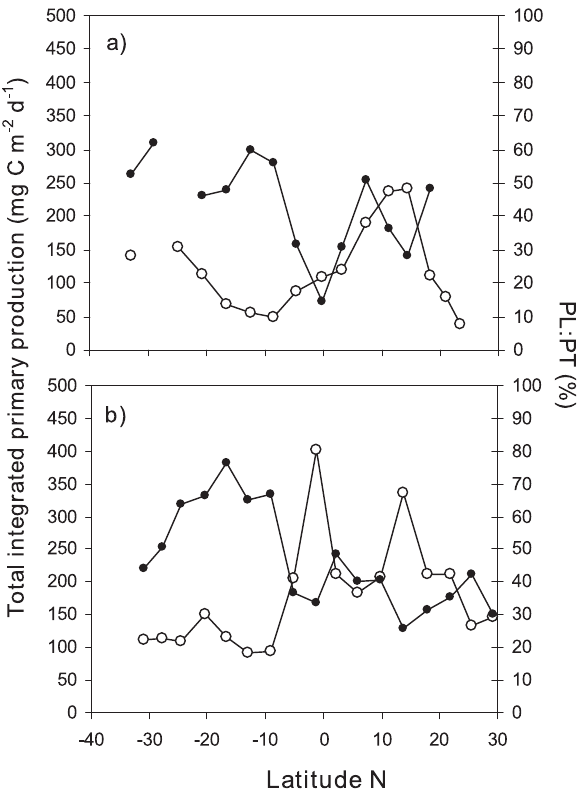
Fig . 7. – Latitudinal distribution of total integrated primary produc- tion (white circles, mg C m -2 d -1 ) and relative contribution of phy- toplankton >2 m m to total integrated primary production (PL:PT, black circles, %). a) Trynitrop 2007; b) Trynitrop